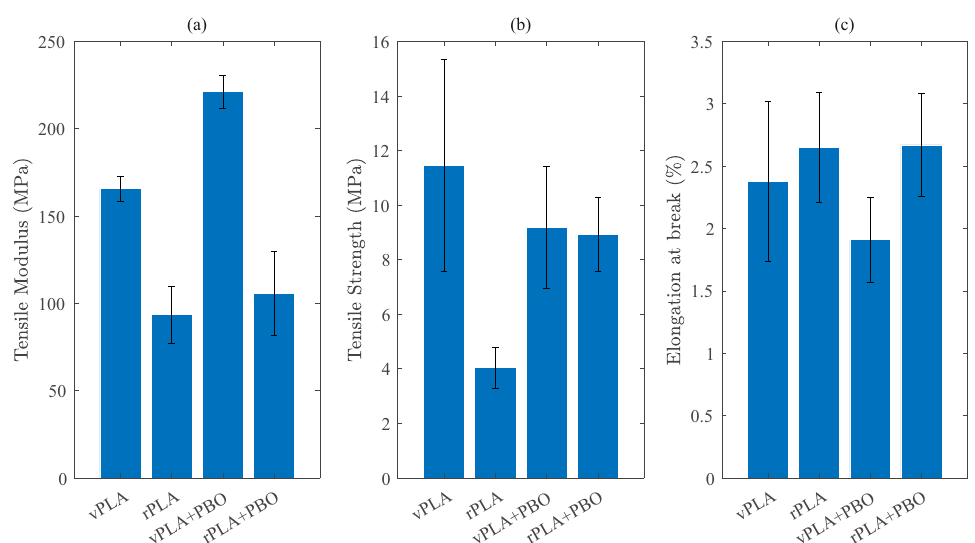
Figure 4. Tensile modulus ( a ), Tensile Strength ( b ), and Elongation at break ( c ) of the filament produced with the virgin PLA (vPLA), recycled PLA (rPLA), virgin PLA mixed in the presence of PBO (vPLA+PBO), and recycled PLA mixed in the presence of PBO